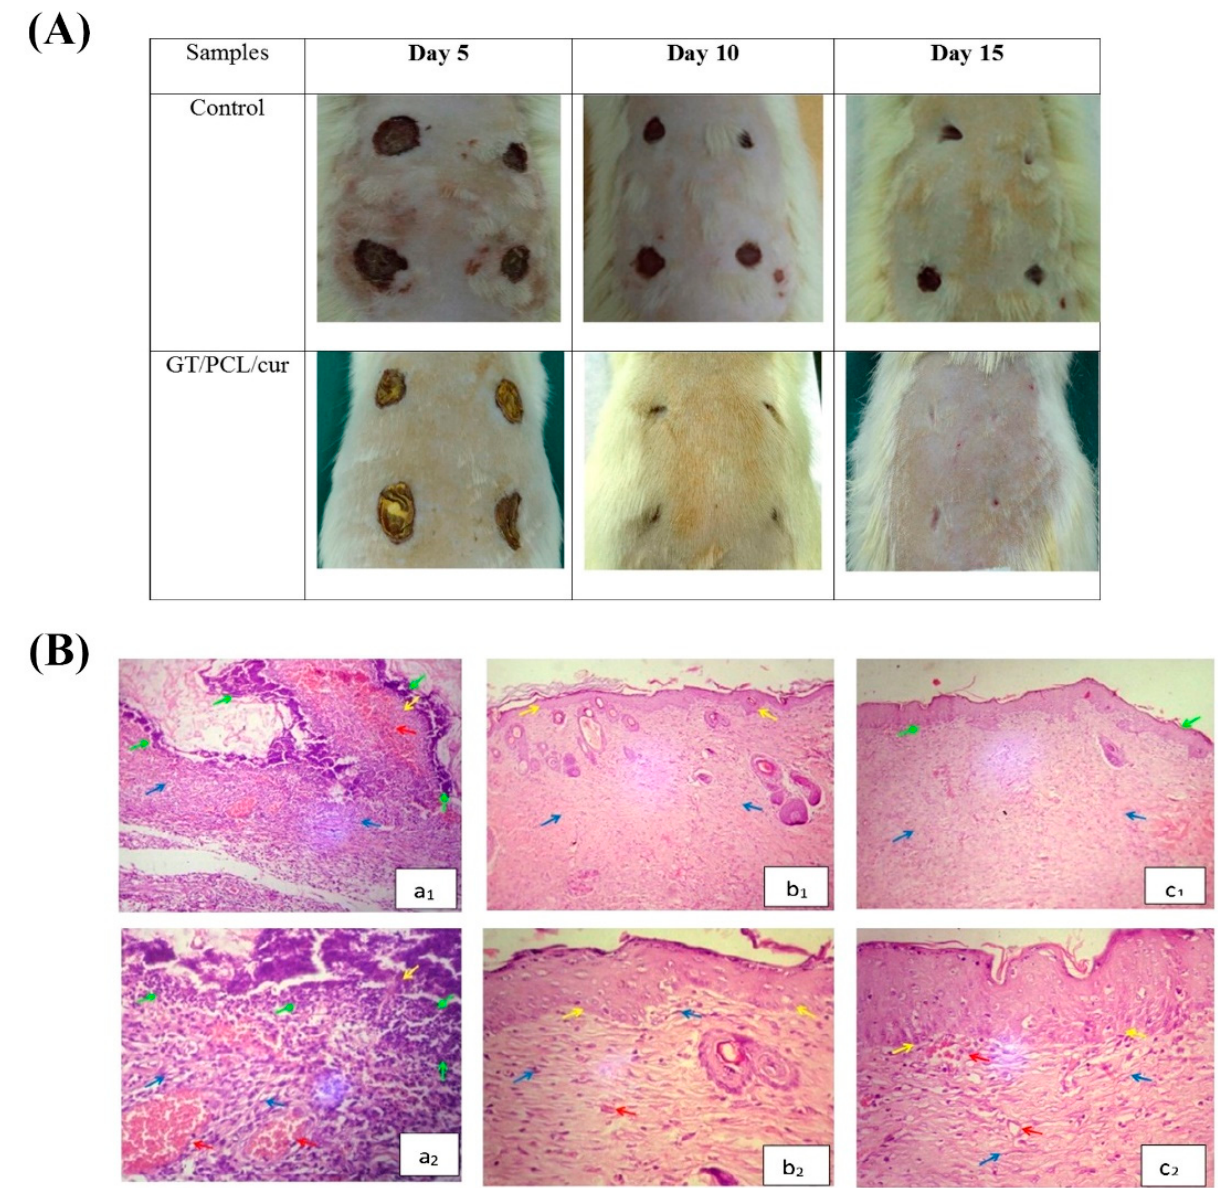
Figure 6. ( A ) Macroscopic observation of the wound closure in un-treated diabetic rats and the animals treated with gum tragacanth (GT)/poly vinyl alcohol (PVA) electrospun nanofibers containing 3% curcumin (Cur) at 5, 10, 15 days post-surgery. ( B ) Microscopic observations of H&E stained slides of the untreated skin wounds ( a1 , a2 ) and those treated with the PCL/GT/Cur nanofibers ( b1 , b2 ) and the PCL/GT/Cur loaded with umbilical cord Wharton jelly-derived mesenchymal stem cells ( c1 , c2 ) after 15 days of surgery. Note that granulation tissue, epithelial regeneration, angiogenesis, and collagen fibers were indicated by blue, yellow, red, and green arrows, respectively. Magnification of a1, b1, c1 is 100 × , and a2, b2, c2 is 400 × . Reproduced with permission from [108], Copyright 2016,